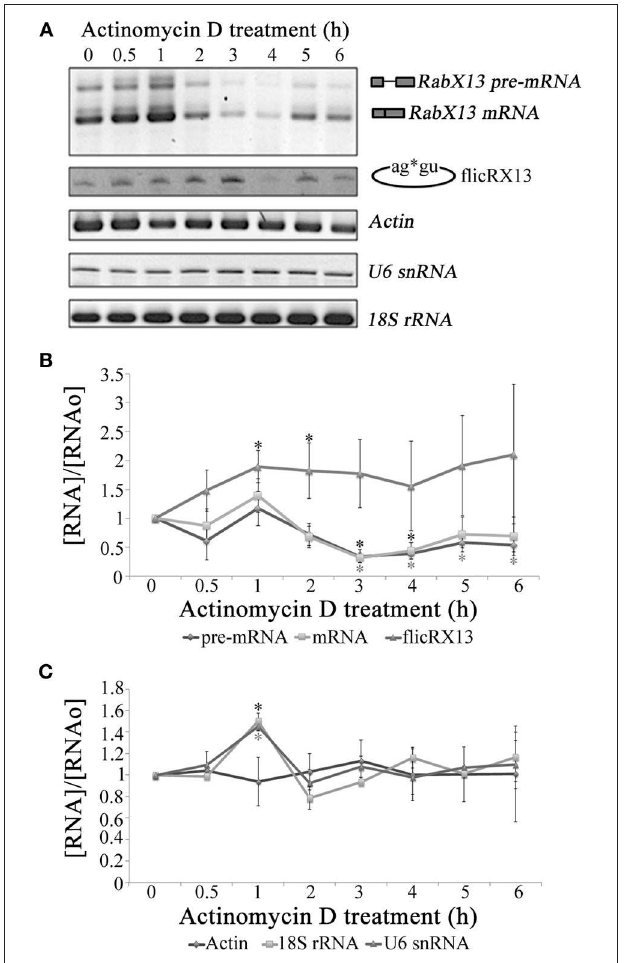
FIGURE 3 | flicRX13 is an RNA processing byproduct and is more stable than its corresponding splicing linear variants. (A) RabX13 gene expression after RNA Pol II inhibition by Actinomycin D. As the loading control EhActin gene expression was analyzed. Pol I (18S rRNA) and Pol III (U6 snRNA) inhibition by Actinomycin D was also monitored. (B) Quantitative analysis of RabX13 gene expression after RNA Pol II inhibition by Actinomycin D shown in (A) . The increase of flicRX13 expression at 1 and 2h posttreatment is significantly different (t-Student P < 0.0061; P < 0.0041, respectively) as well as the decrease in pre-mRNA and mRNA (t-Student P < 0.001 at 3h; black and gray asterisks, respectively). (C) Quantitative analysis of 18S rRNA, U6 snRNA and EhActin gene expression after RNA Pol II inhibition by Actinomycin D shown in (A) . The increases in 18S rRNA and U6 snRNA (black and gray asterisks, respectively) are statistically significative (t-Student P < 0.001).